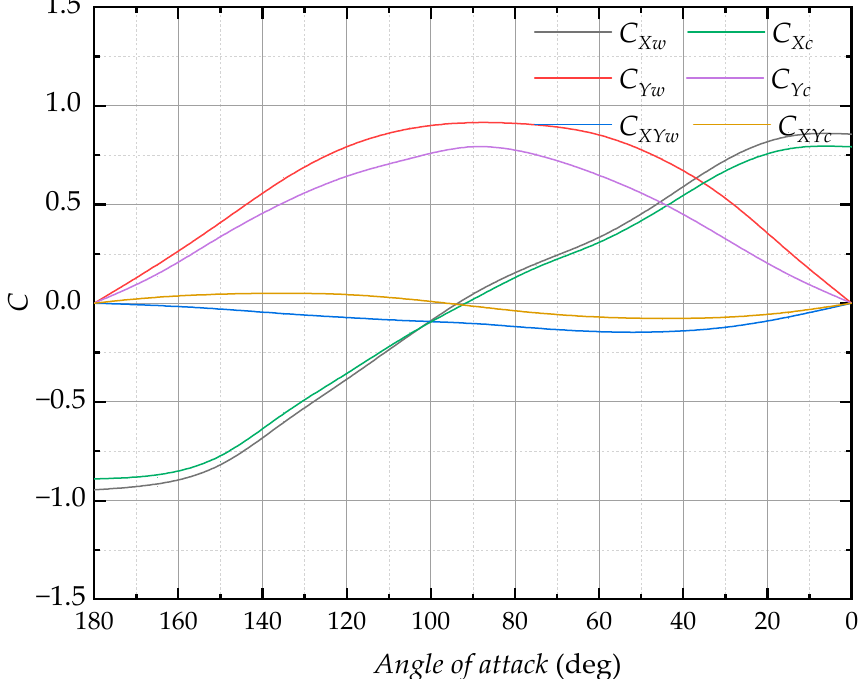
Figure 5. Environment load coefficients.